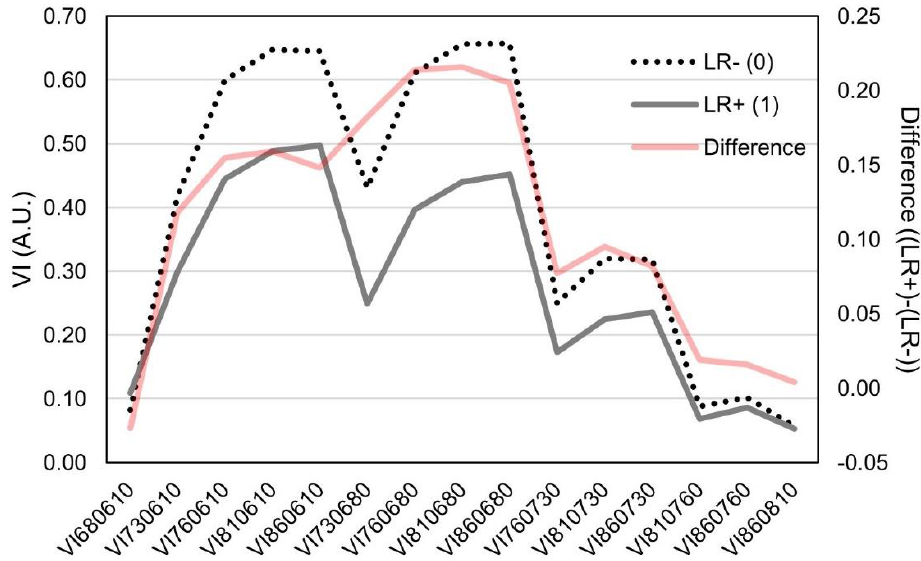
Figure 4. Plot of different normalized difference vegetation indices (VI) in arbitrary units (A.U.) between plots showing leaf rolling (LR+) and plots without leaf rolling (LR-) and their respective differences. Standard deviations of the VIs are.